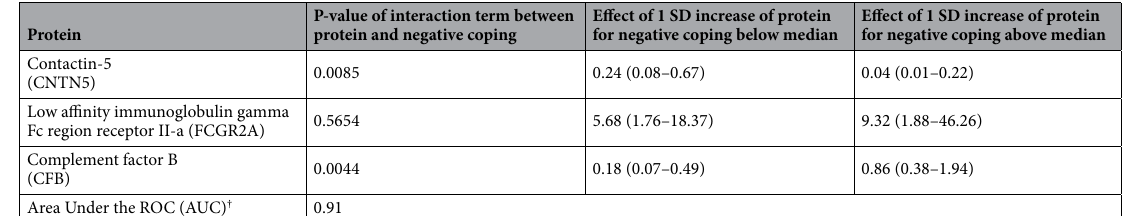
Table 5. Influence of Religious struggle on Associations between Proteins and Incident CVD Using Linear Contrasts * . *The linear contrasts came from the interaction terms of proteins and the median-based negative coping variable. Three interaction terms were included in the main effects model shown in Table 3. Shown are the odds ratios and 95% confidence interval for each stratum of negative coping. † AUC from main effects model + interaction term of religious struggle x